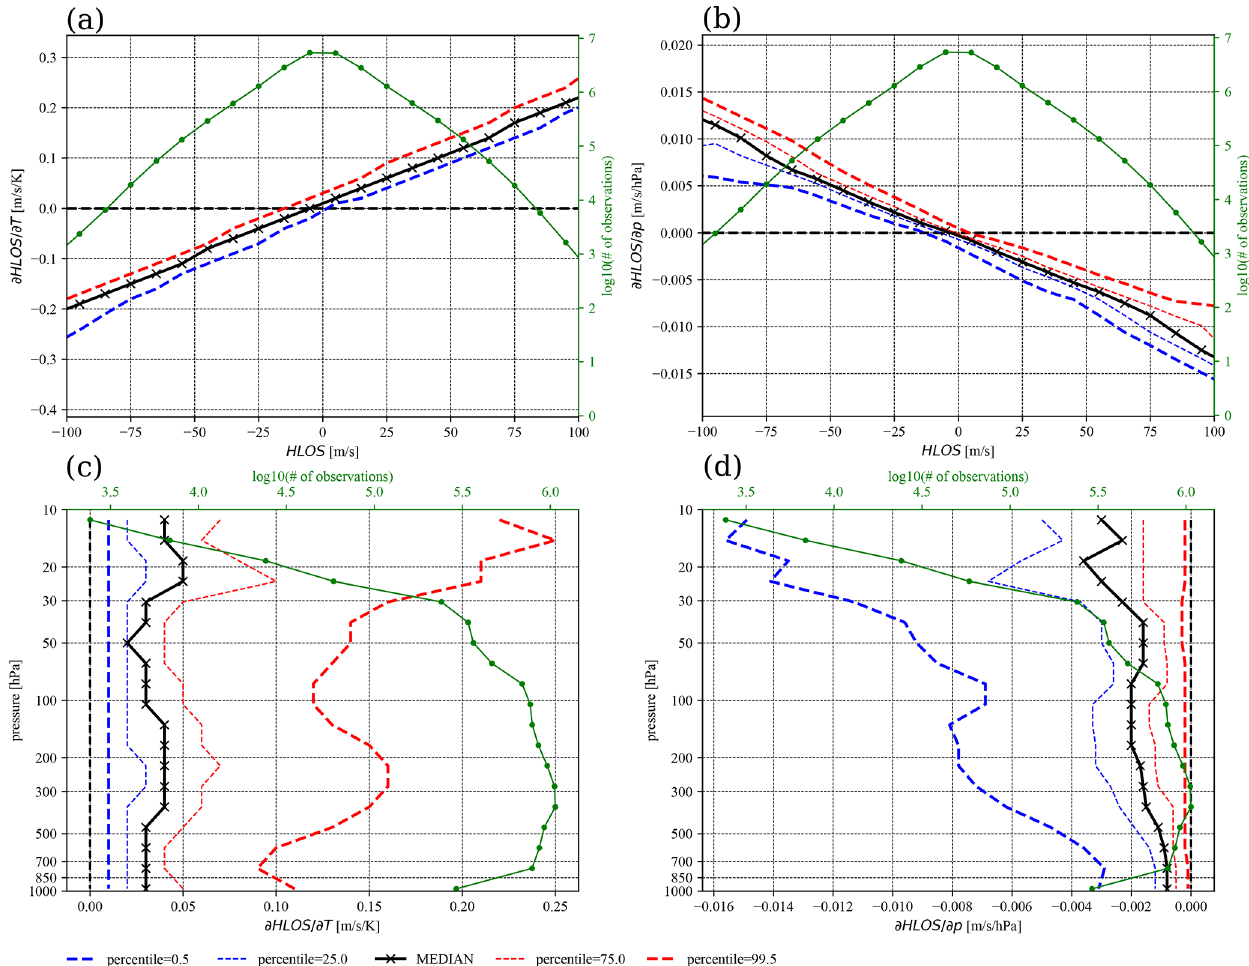
Figure 3. The HLOS sensitivity (a, c) with respect to temperature (i.e. ∂ T HLOS) and (b, d) with respect to pressure (i.e. ∂ p HLOS) over a 5-month period (1 August to 31 December 2019). (a, b) The sensitivity is shown as a function of HLOS wind velocity. The median and several percentiles are computed by gathering all available and valid data in HLOS bins of 10ms − 1 . (c, d) The sensitivity is shown as a function of pressure taking into account only data with positive HLOS wind velocity. The amount of available data in a bin (solid